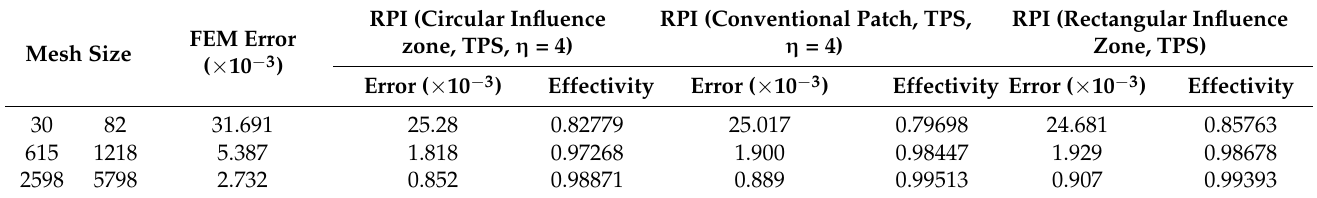
Table 5. Error properties results for RPI (TPS)-based recovery techniques in incompressible-elastic plate analysis considering influence zones and conventional patches (four-node quadrilateral irregular mesh). Table 7. Adaptive finite element analysis results (overall errors, total number of elements (N) and DOF) for incompressible-elastic plate with 4% target error using quadrilateral elements.